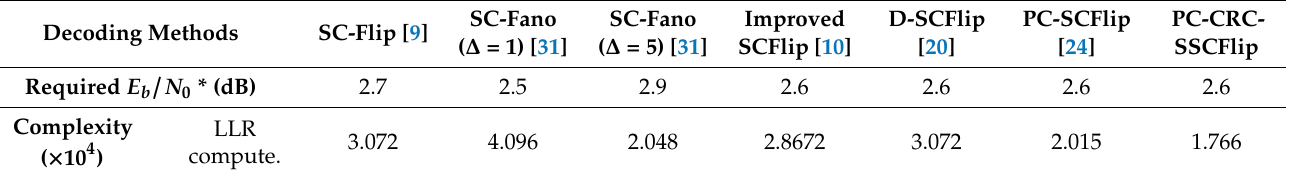
Table 3. Average LLRs computation comparison of the proposed method with different SC flip decoders for (1024, 512) polar codes with 24 check